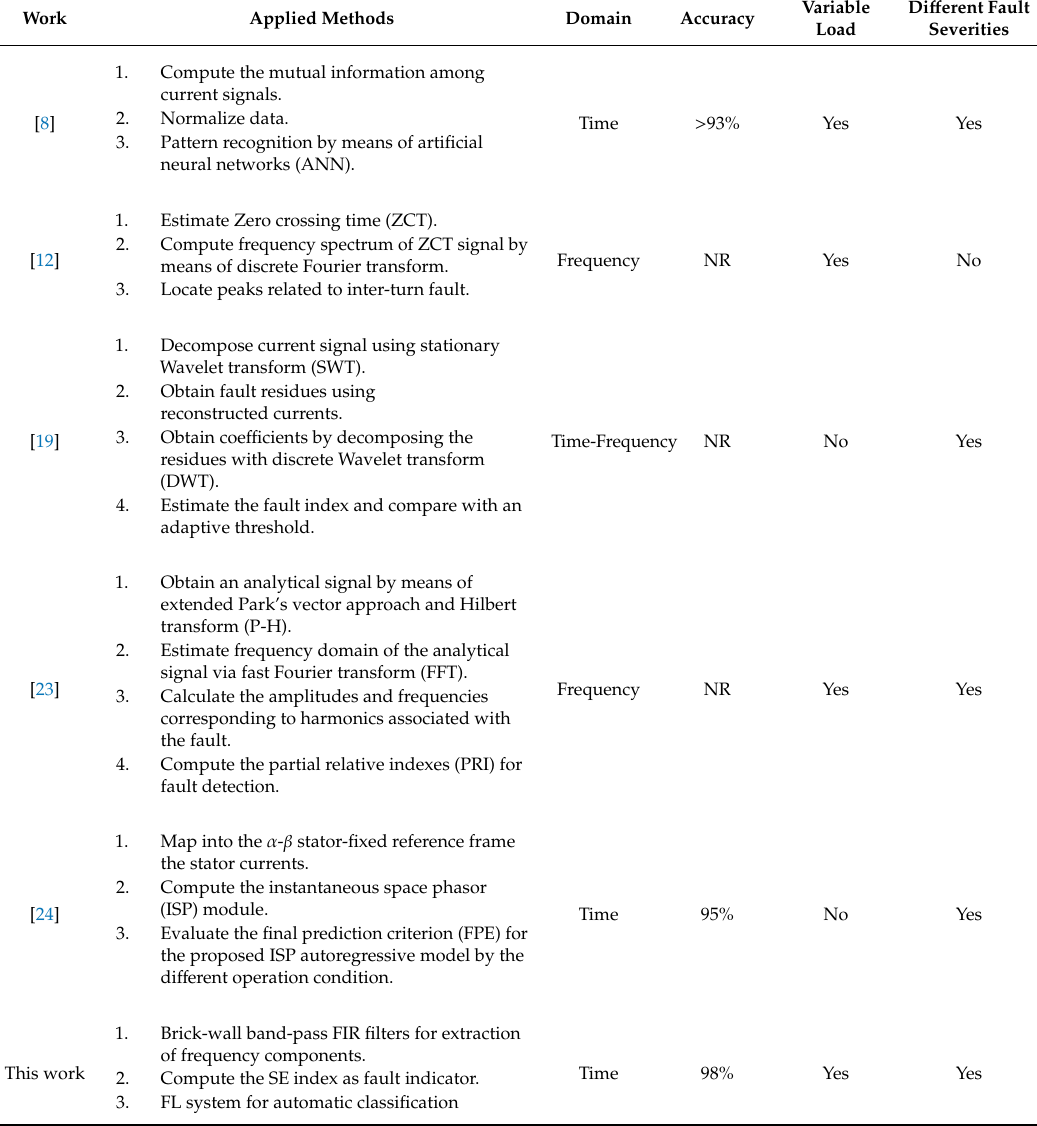
Table 4. Comparison summary between the proposed methodology and works reporting stator winding short-circuit (SWSC) fault